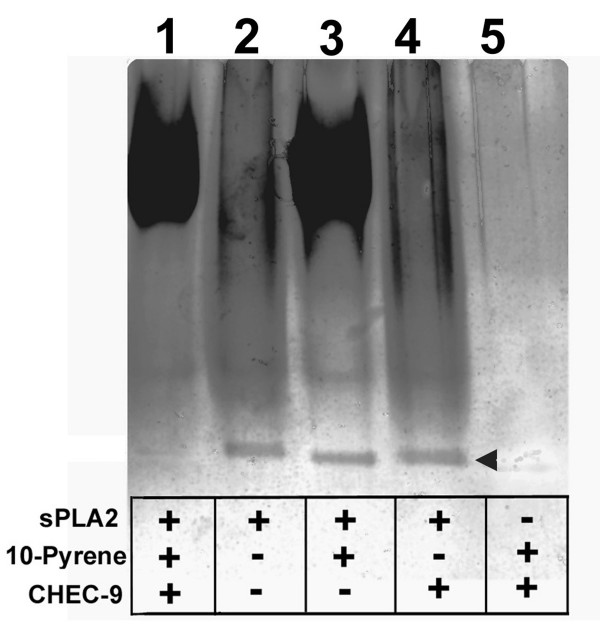
Silver-stained SDS gel showing the migration of sPLA2 group I on native gels. The enzyme was incubated with various components of the reaction mixture in calcium containing buffer as described in Methods. The sPLA2 band (arrowhead) disappeared or was markedly attenuated when the enzyme was pre-incubated with both peptide and substrate (lane 1), but not after incubation with buffer, substrate, or peptide alone (lanes 2, 3, 4). The gels suggested that the peptide could modify the structure and/or binding properties of the enzyme only in the presence of substrate.